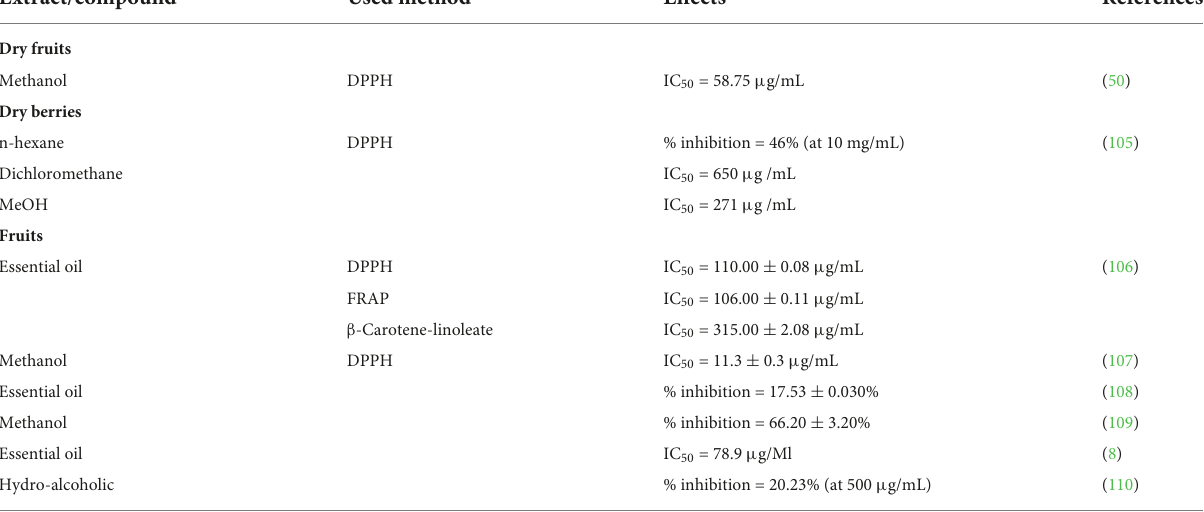
TABLE 4 Antioxidant activity of P. cubeba